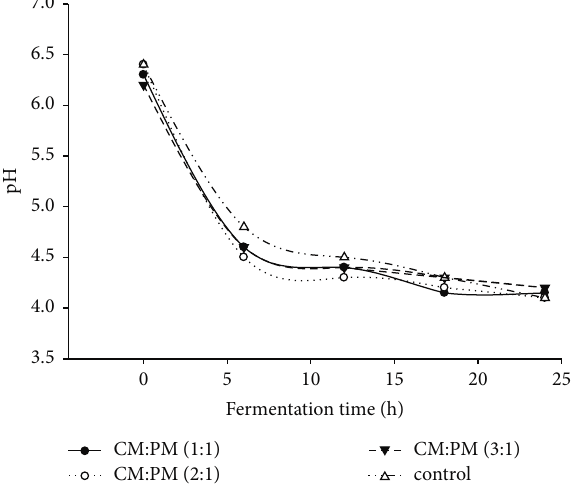
Figure 3: The pH values of four samples at different fermentation times. All the values are expressed as mean ± SD ( n � 3). CM, cowpea milk; PM, peanut milk.